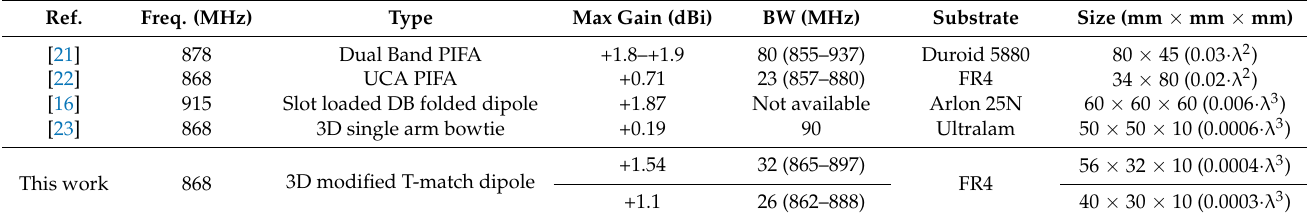
Slot loaded DB folded dipole